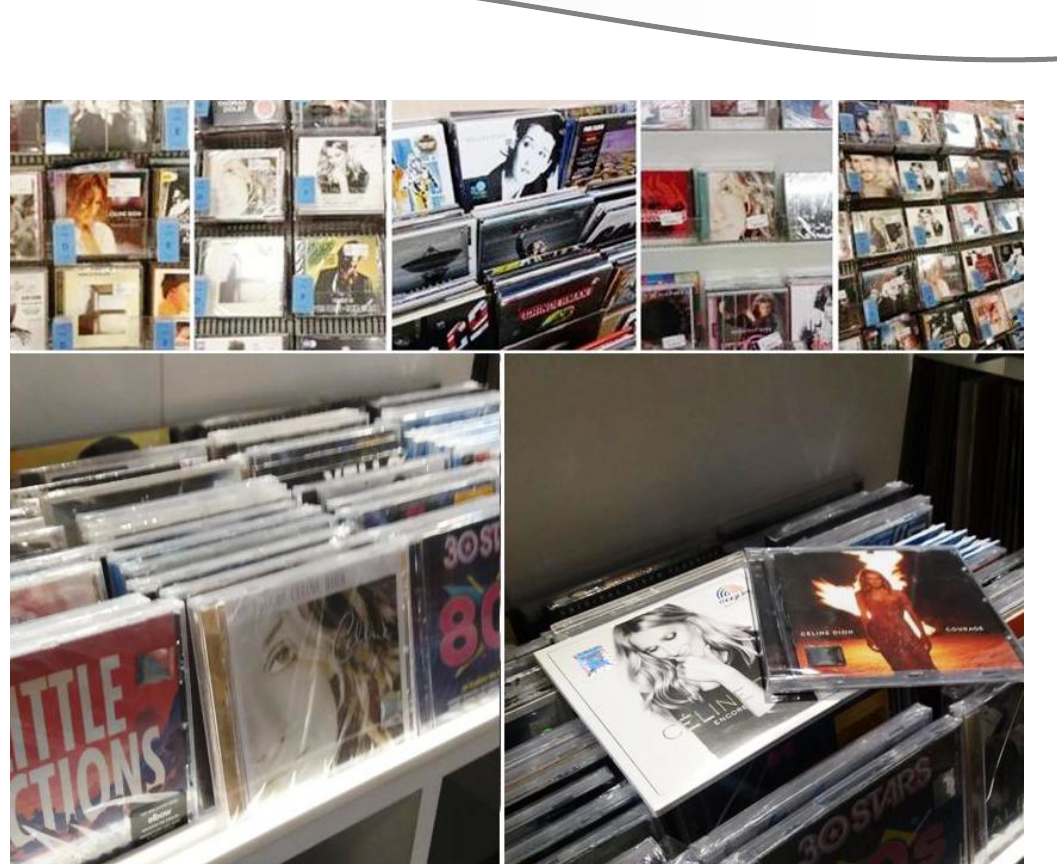
Figure 8: Dion’s albums on - sale in Villach (Austria), Budapest (Hungary), Bucharest & Braş ov (Romania) (from vinyl D’Eux album, upper - middle, to Encore un soir and Courage CDs, lower - right side). Source: authors’ photos 2018 – 2019 Table 6: Statistics on YouTube vi deo views with like rates and commentaries Analyzed songs Views Rate of likes %